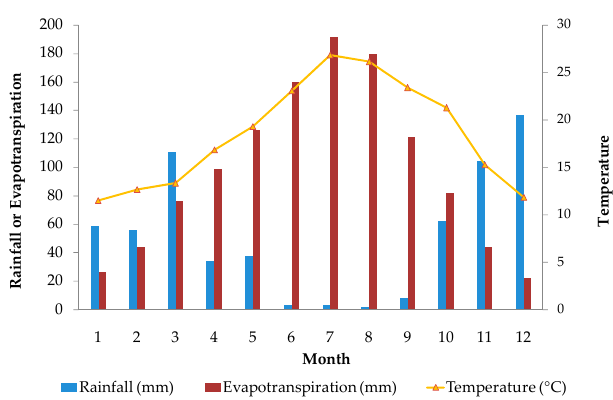
Figure 2. Monthly averages of precipitation, temperature and evapotranspiration.